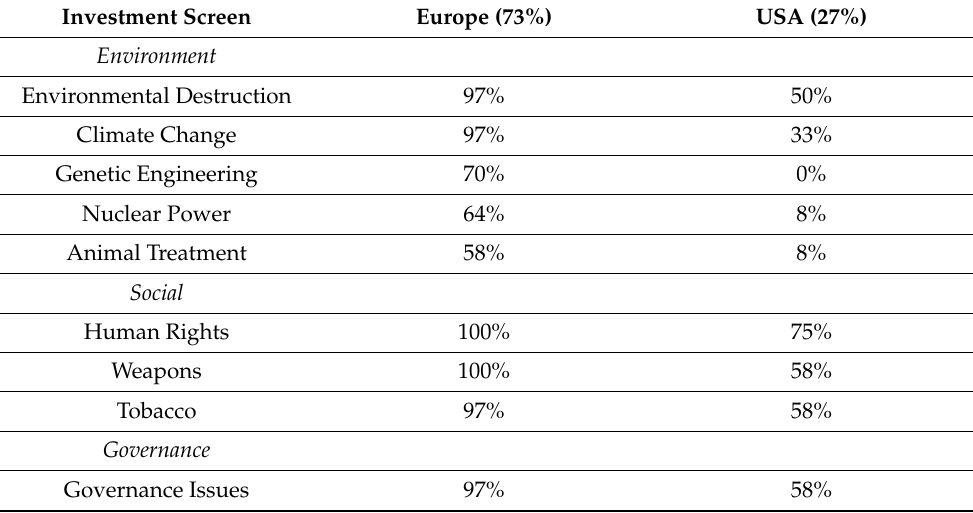
Table 3. Comparison of relevant topics of concern for CIF providers in Europe and the United States. Investment